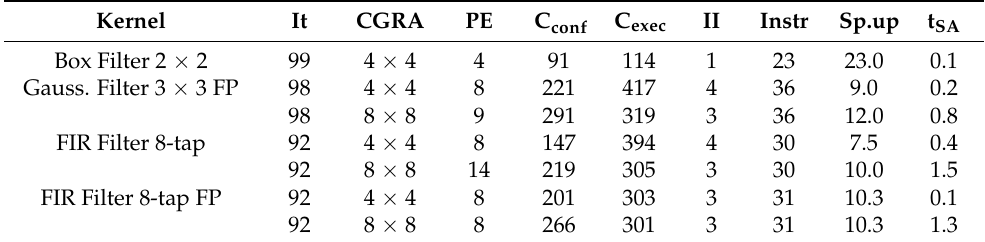
Table 2. Filter kernel